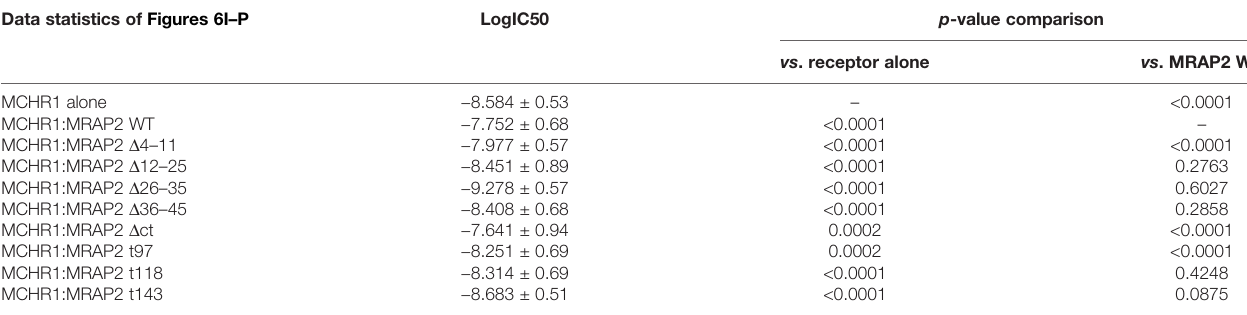
TABLE 2 | Statistical analysis of MCHR1 in the presence of different MRAP2 mutants in response to the antagonist of MCHR1. Data statistics of Figures 6I –